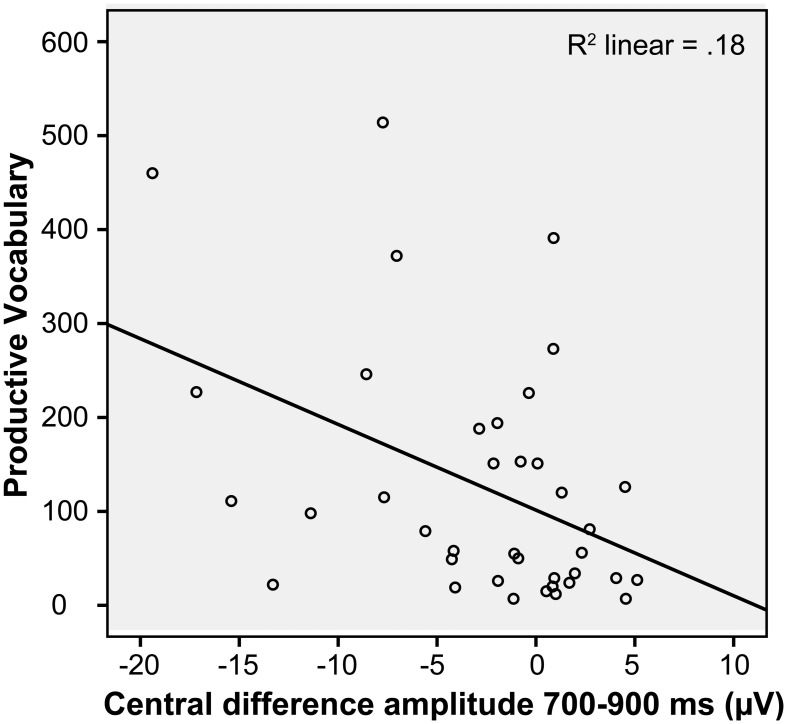
Relation between productive vocabulary and the difference in amplitude between congruous and incongruous words in the silhouette condition (in the 700 and 900 ms time window over central electrodes), at 20 months. Note that a negative difference score corresponds to a greater negativity to the incongruous presentation, while a positive difference score corresponds to the opposite pattern of response.